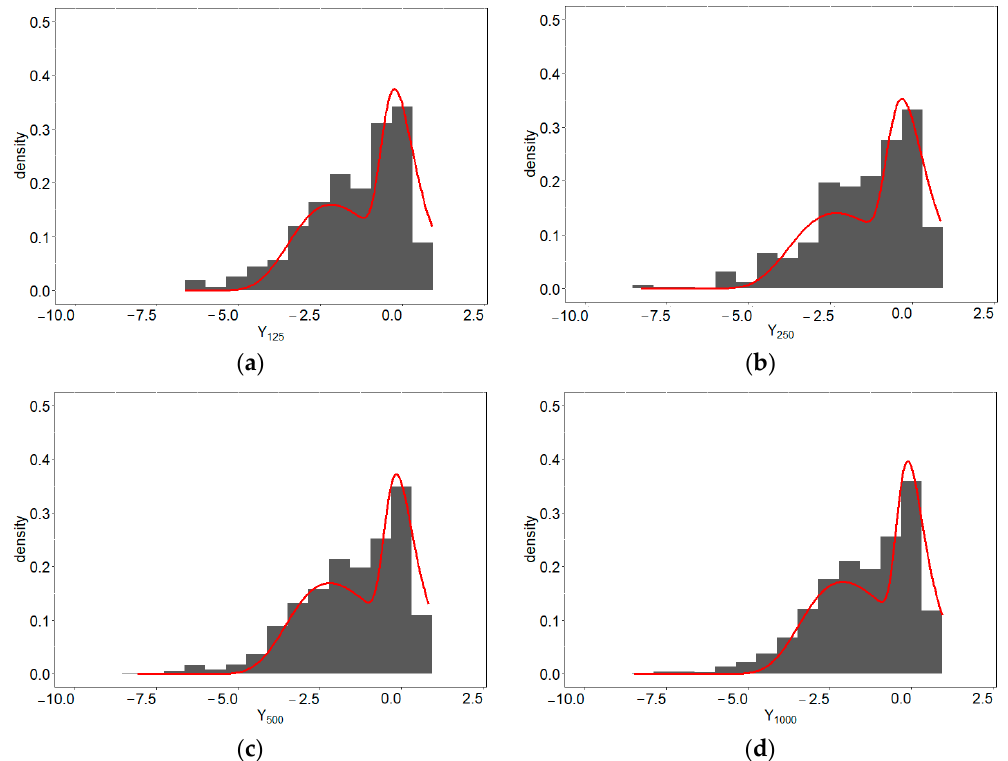
Figure 2. Histograms and predictive densities for the two-component EV-I mixture distribution with ( a ) 125, ( b ) 250, ( c ) 500, and ( d ) 1000 samples per component.